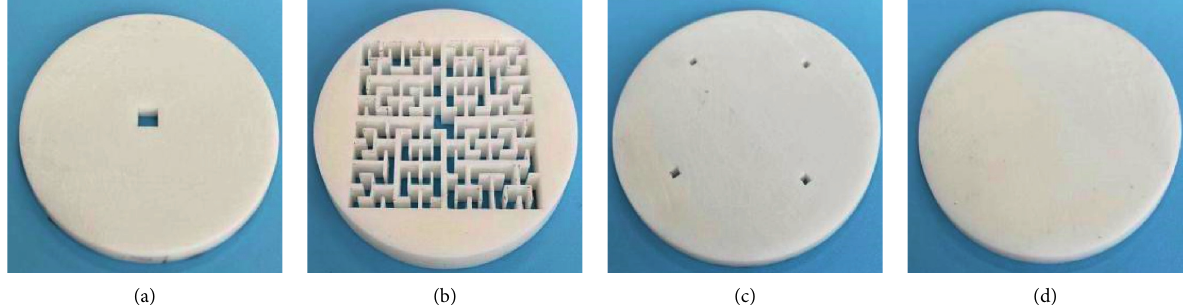
Figure 15: Structure of each layer of the model. (a) Centre perforated plate. (b) Coiled channel plate. (c) Perimeter perforated plate. (d) Closure plate.